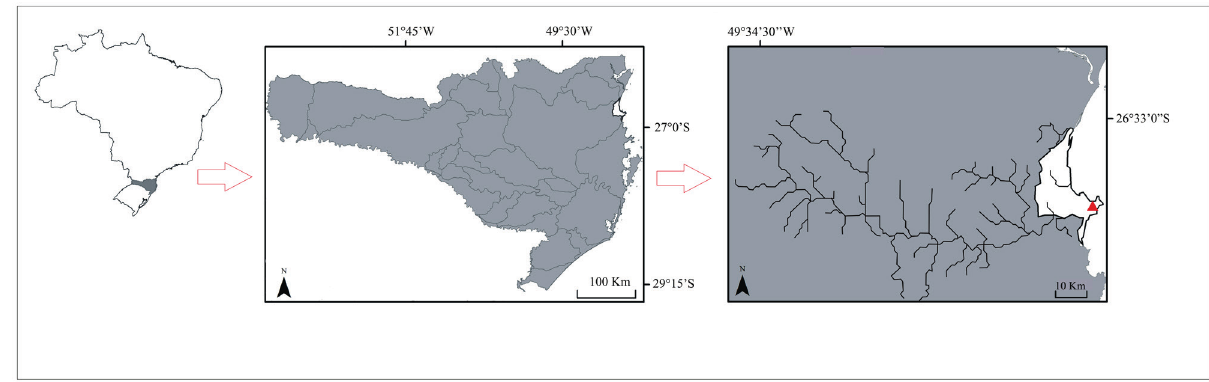
Figure 5. Distribution of Parastacus tuerkayi sp. nov. in the state of Santa Catarina, southern Brazil. The type locality is represented by a red